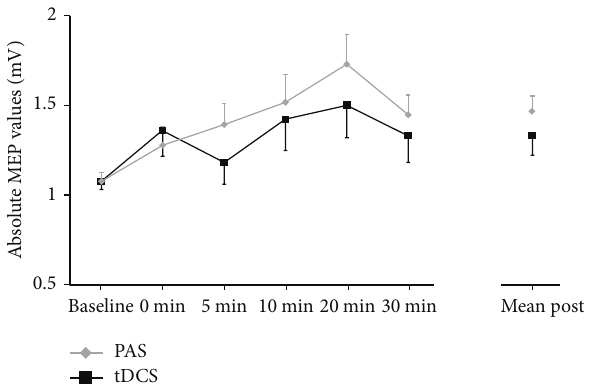
Figure 2: MEP values at baseline and all time points following anodal tDCS and PAS. MEP values are shown as untransformed values and scaled in mV and error bars representing the standard error of the